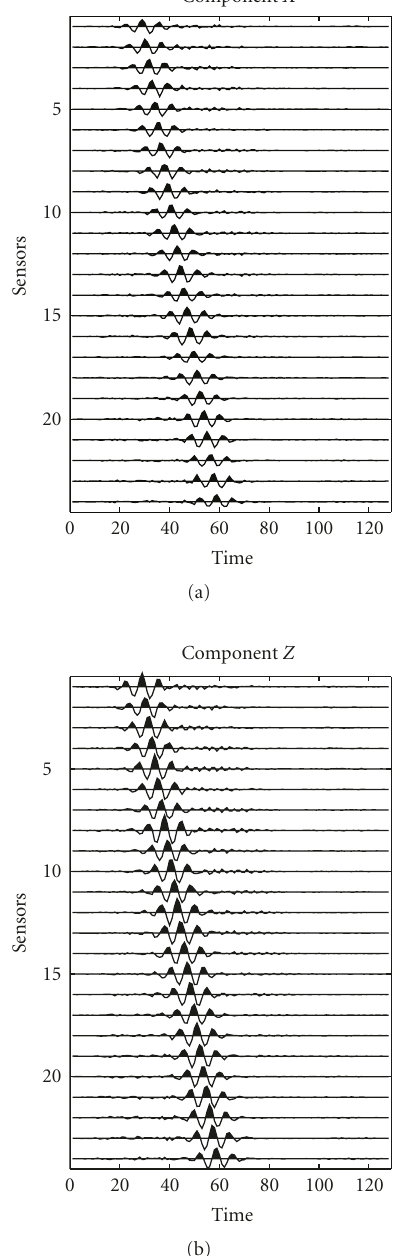
Figure 10: First extracted wave after projection of initial dataset onto the first eigenvector. (a) Component X , (b) Component Z.